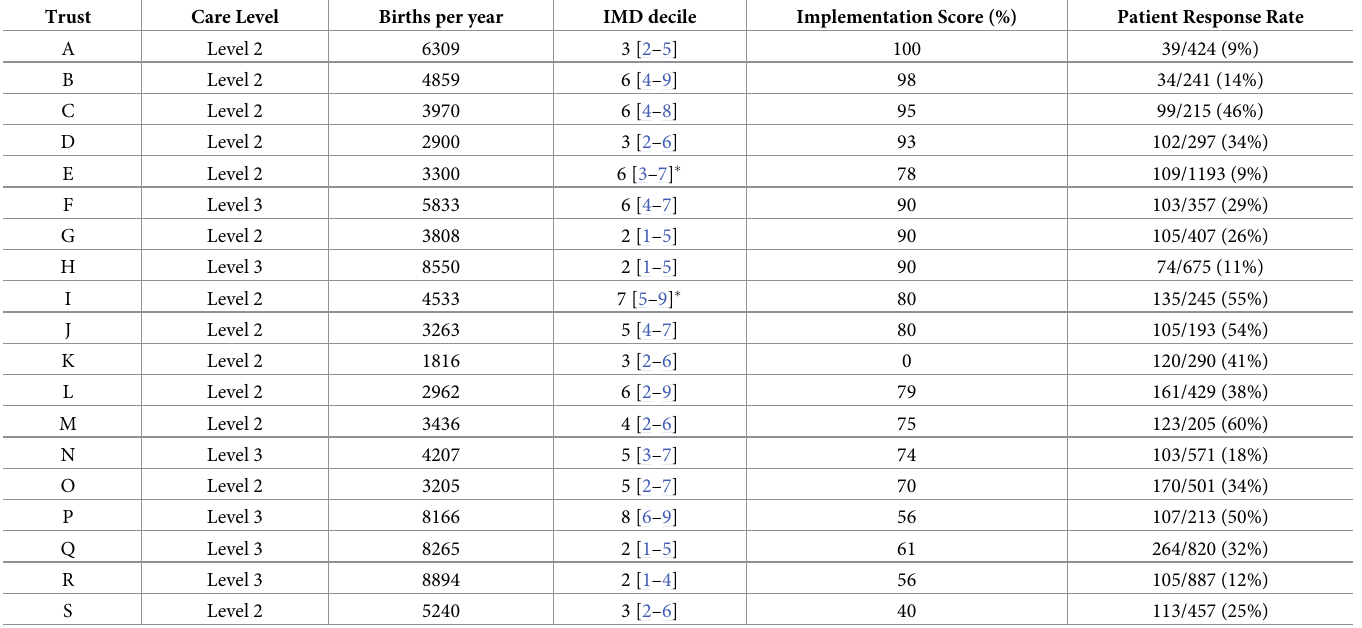
Table 1. Characteristics of participating